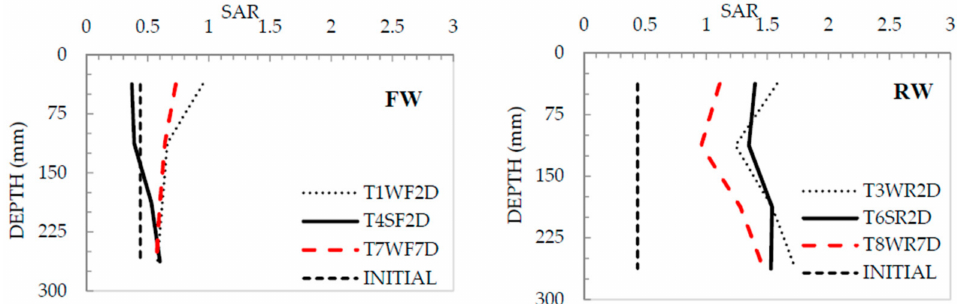
Figure 7. Soil sodium absorption ratio (SAR) at different soil depths for fresh water (FW) ( left ) and recycled water (RW) treatments ( right ). See Table 2 for treatment descriptions.